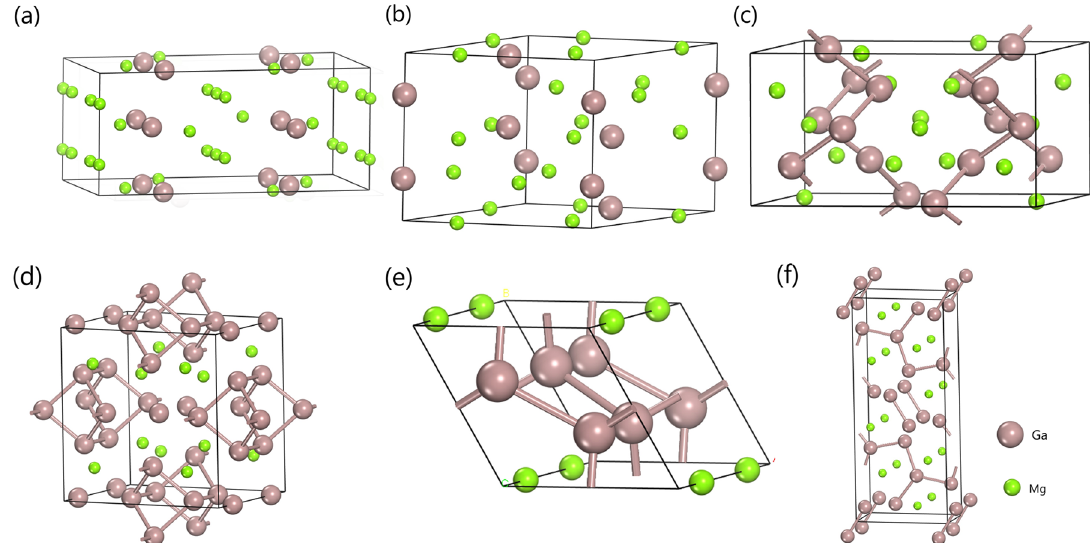
Mg ; (b) GaMg ; (c) GaMg; (d) Ga 2 5 2 ) and formation enthalpy (ΔH coh